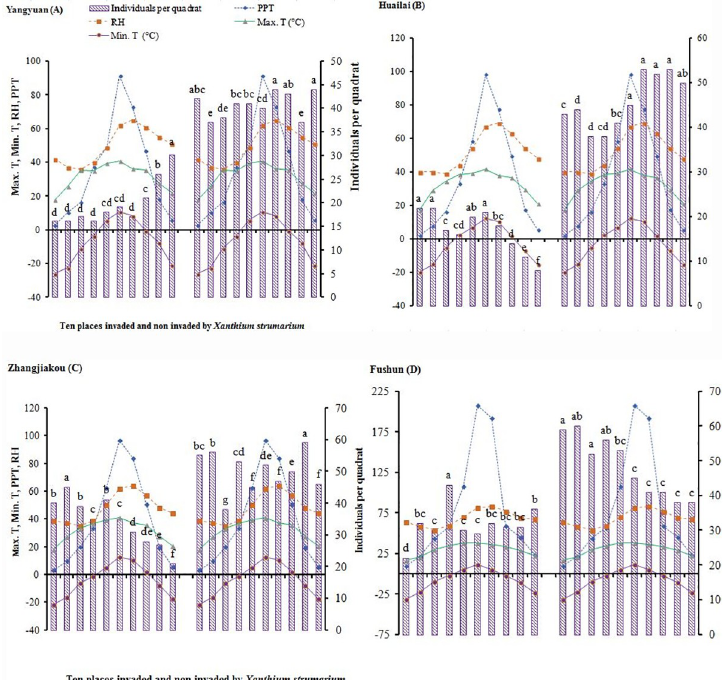
Fig 2. Number of plant individuals per quadrat ( N = 10) and environmental factors (from February to November in 2018) found at ten invaded and ten non-invaded quadrats in Yangyuan (A), Huailai (B), Zhangjiakou (C) and Fushun (D), respectively. Max. T., average of monthly mean maximum temperature; Mini. T., average of monthly mean minimum temperature; RH, average of monthly mean relative humidity; PPT, average of monthly mean precipitation. Different letters indicates significant difference ( P < 0.05; analysis of